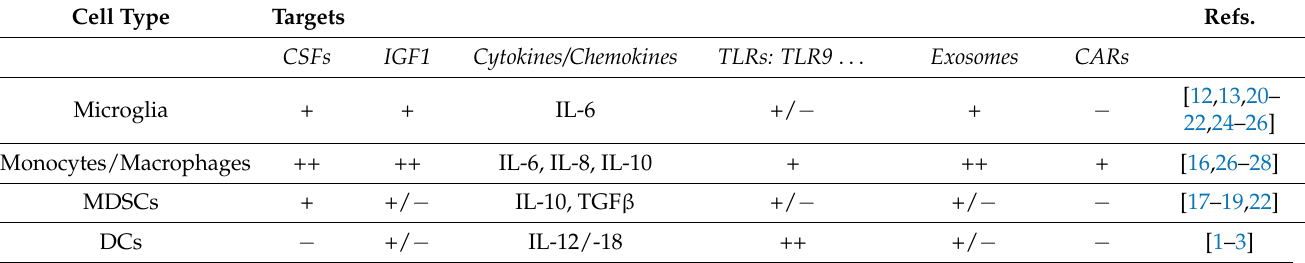
Table 3. Targeting Myeloid Cell Populations in